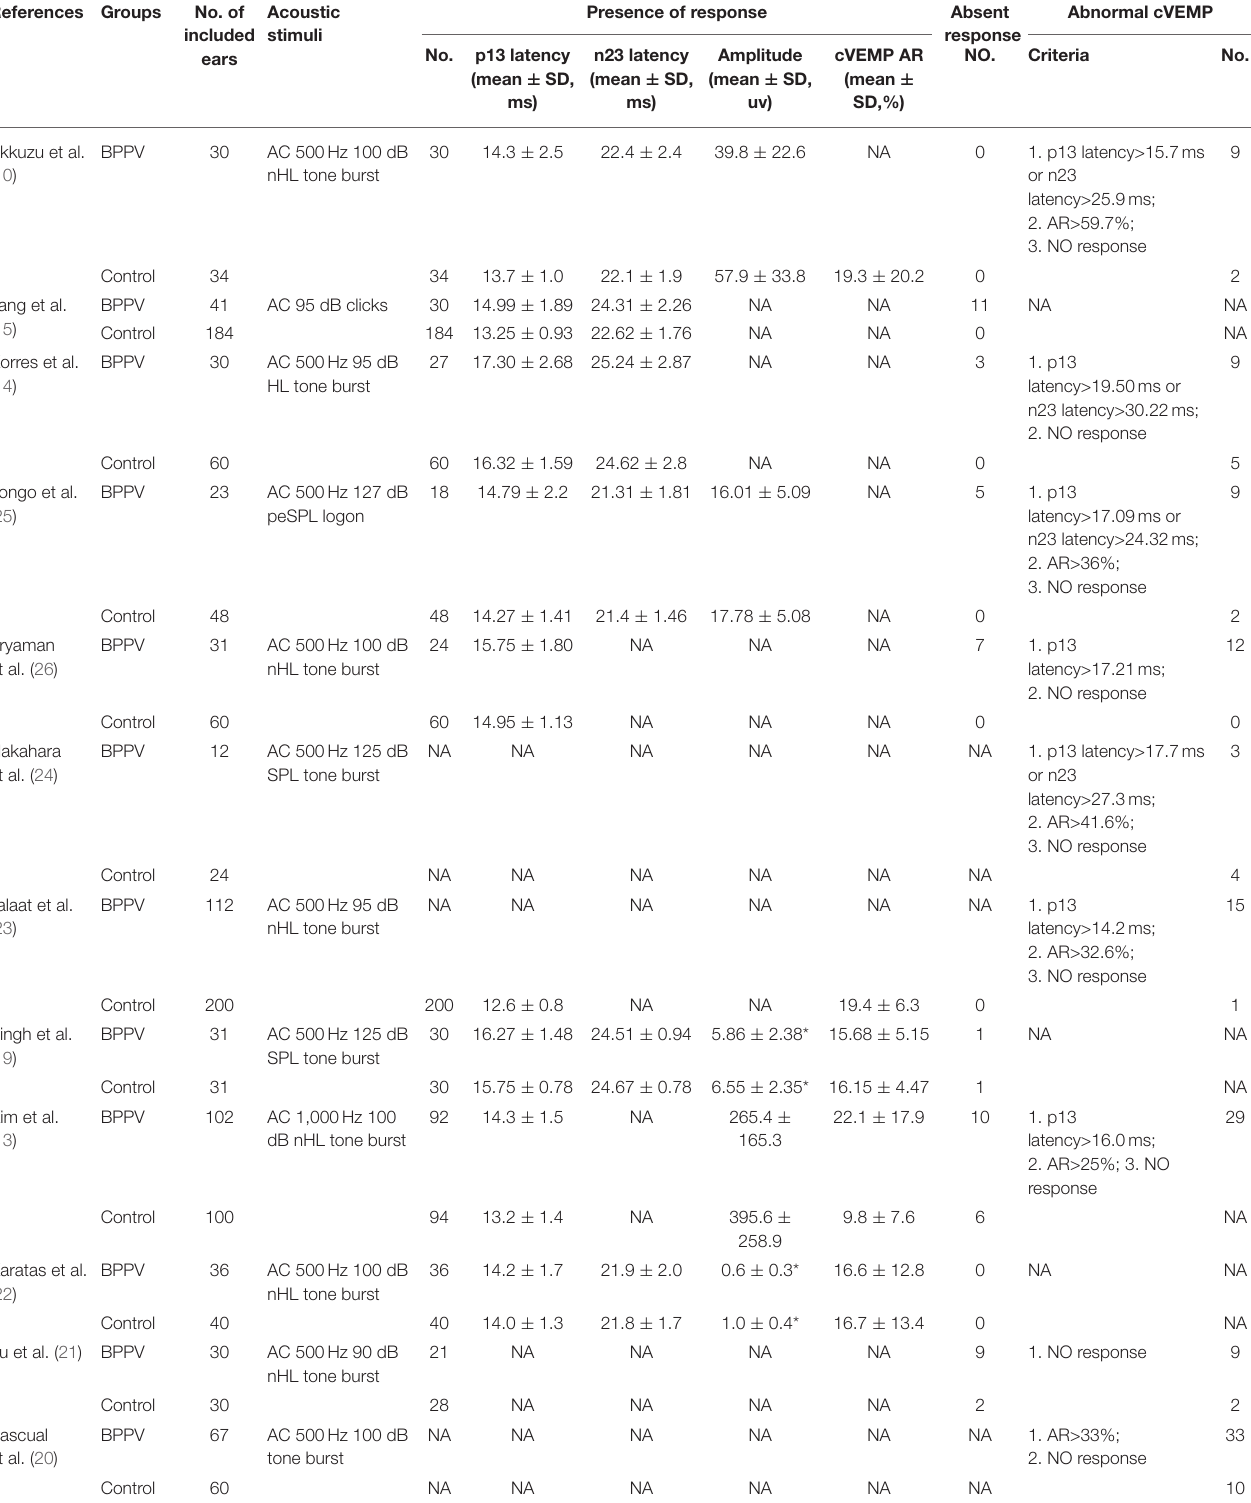
TABLE 2 | The detailed results of cervical vestibular evoked myogenic potentials (cVEMP) test. References